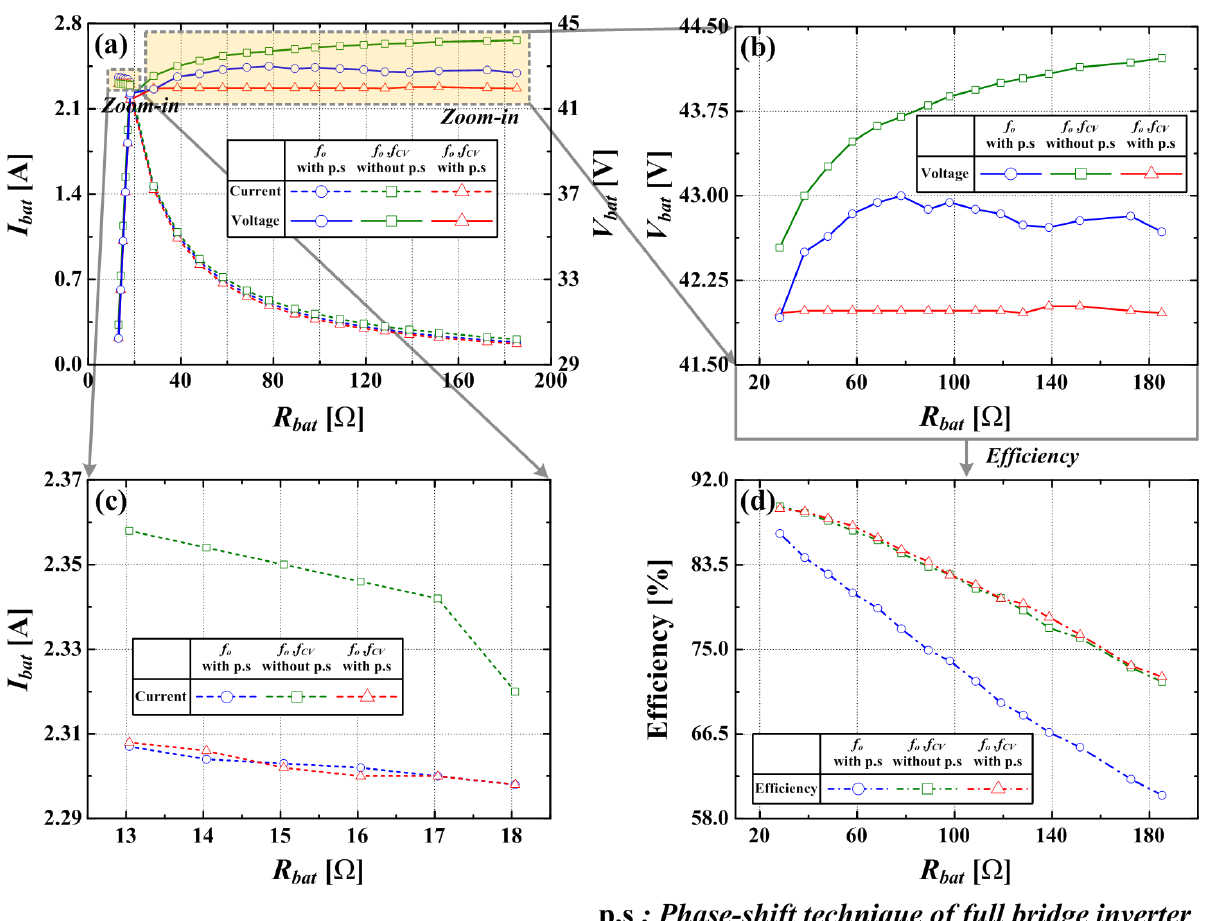
Figure 9. Comparison of V bat , I bat regulation and power efficiency by using k ps , pd and M ps , pd . The receiver coil was located at x = 6 cm, y = 0 cm. ( a ) I bat and V bat regulation result, ( b ) zoom-in waveform of voltage regulation, ( c ) zoom-in waveform of current regulation, and ( d ) power efficiency in CV mode.